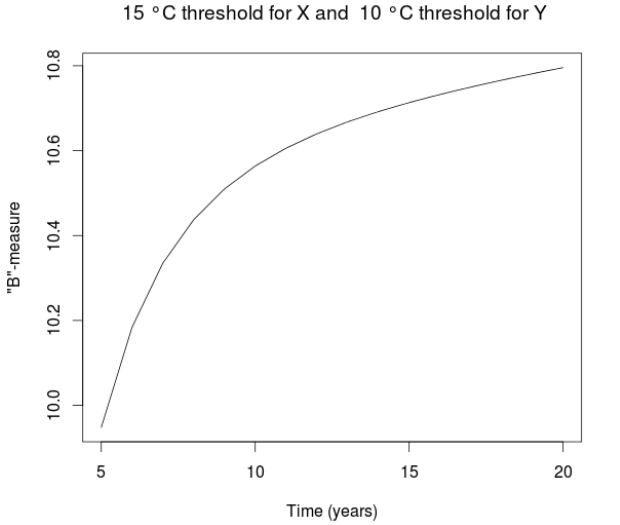
Figure 7. B-measure for the model described in Subsection 3.1 with initial temperature equal to 15 ◦ C for the minimal temperature, 22 ◦ C for the maximum temperature and threshold equal to 10 ◦ C for the minimum temperature and 15 ◦ C for the maximum temperature. The time of maturity is equal to five years. B-measure is plotted as a function of σ to 10